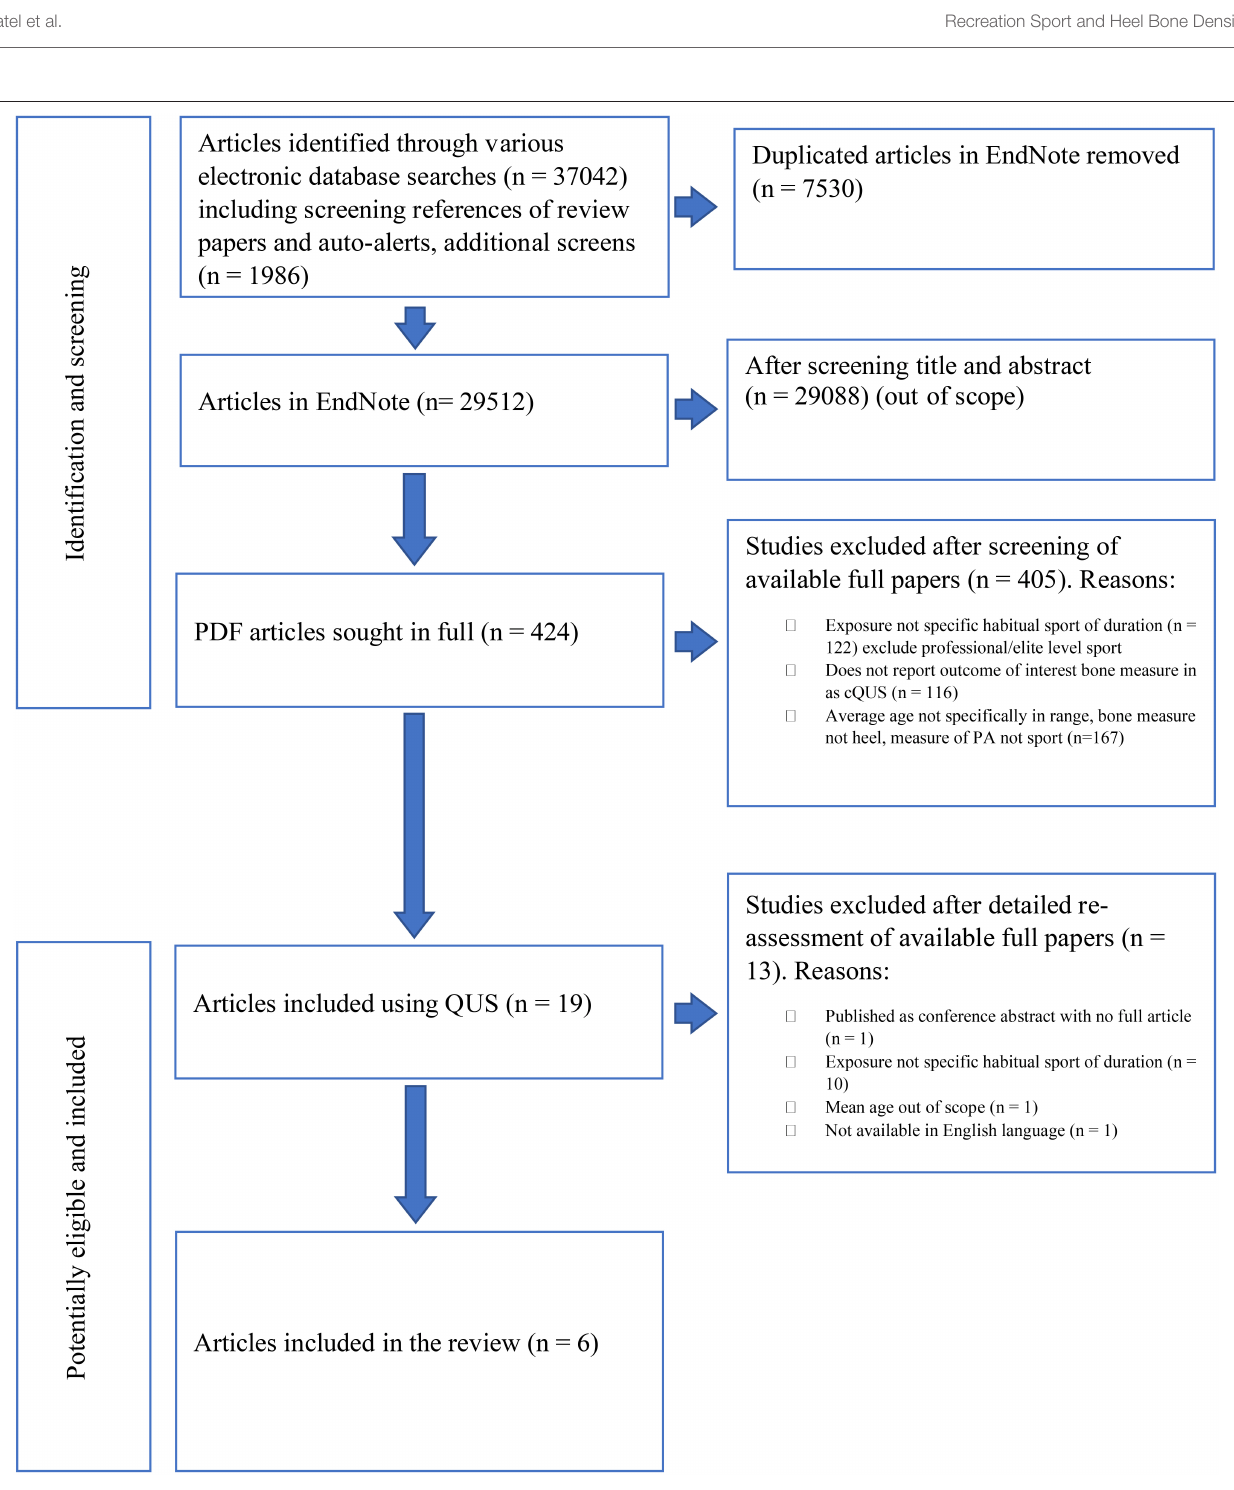
(Gomez-Bruton et al., 2015). In Madic et al.’s Serbian study of 62 participants, male soccer players were compared to controls who participated in regular school based sporting activity only (Madic et al., 2010). Yung et al.’s study of 55 Chinese male university students compared the bone effects of weight-bearing sports